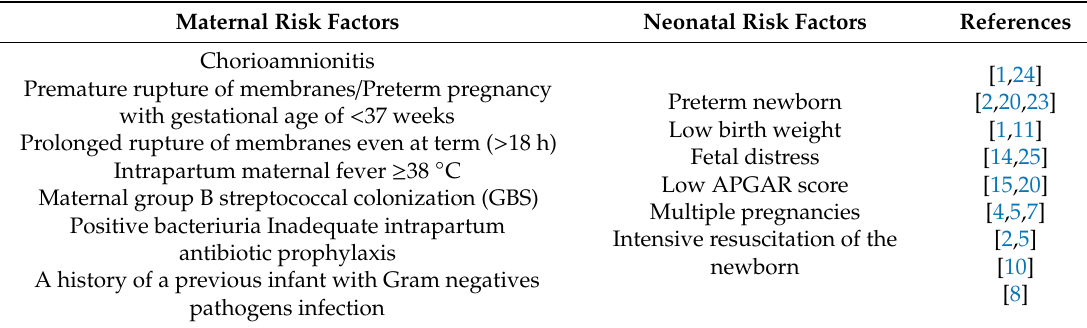
Table 1. Risk factors for neonatal early-onset sepsis